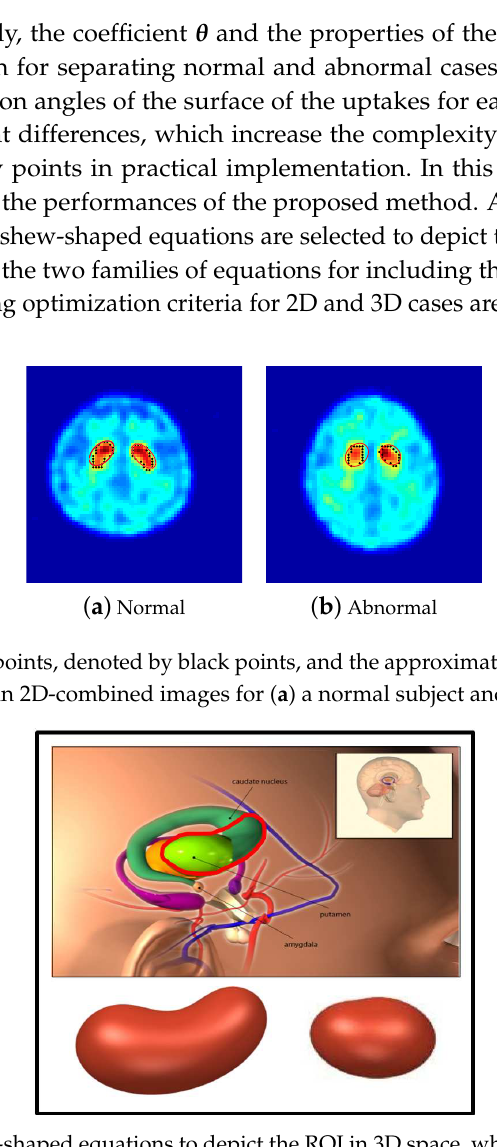
Figure 3. The 3D cashew-shaped equations to depict the ROI in 3D space, where the figure in the upper panel is downloaded from http://www.3d-brain.ki.se/atlas/images/basal_ganglia01.jpg, and the area marked with a red circle denotes the most active region of the highest-uptake. The left and right cashew-shaped structures shown in the lower panel are examples for a normal case and a PD case with two specific settings of the coefficients of the cashew-shaped equation defined in (4),